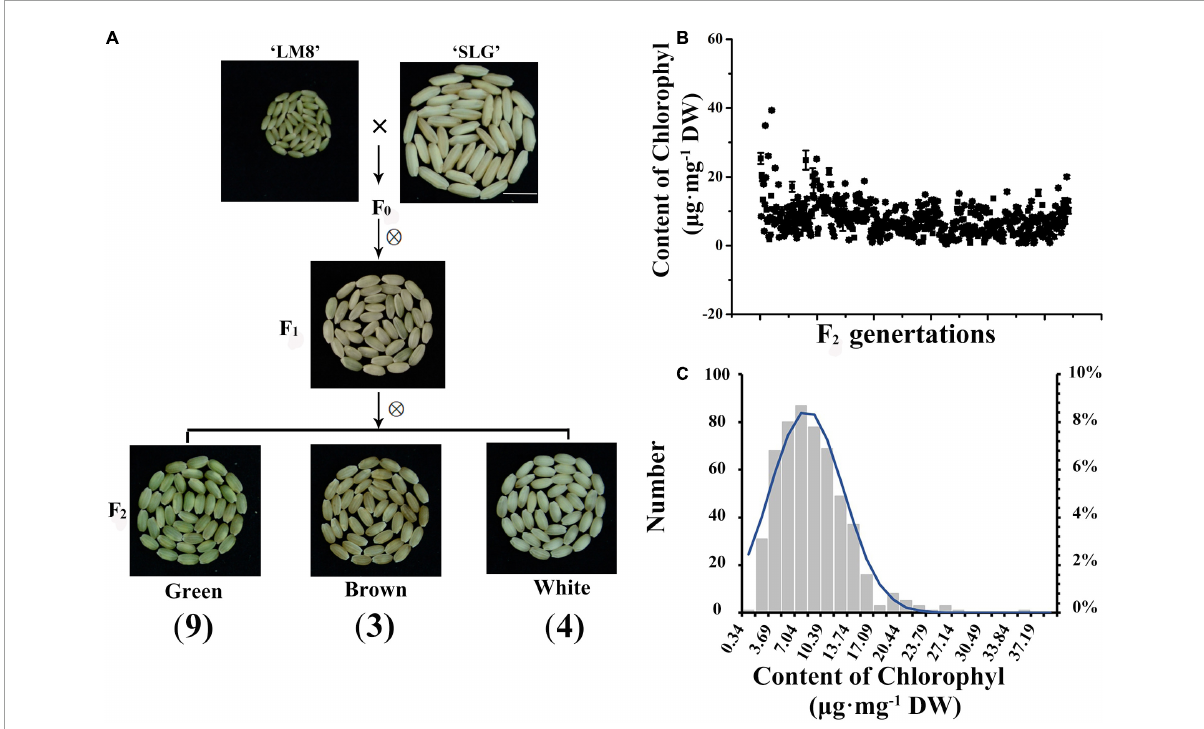
FIGURE3 Segregation analyses of pericarp colors and chlorophyll contents of green pericarps in the F 2 population. (A) LM8 (green pericarp) was crossed with SLG (white pericarp). The F 1 grains produced green and brown pericarps. Additionally, F 2 grains with green, brown, and white pericarps were detected. (B) Chlorophyll contents. (C) Normal distribution curve analysis.